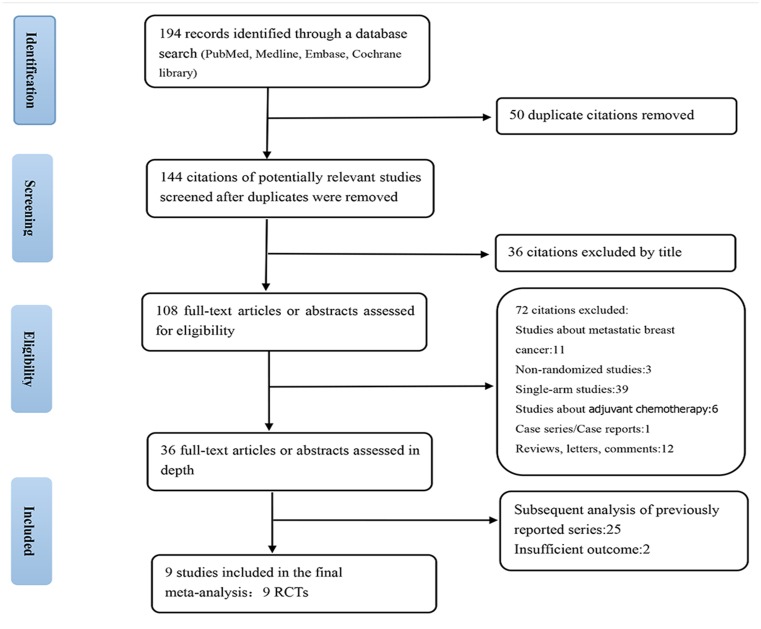
Study selection.